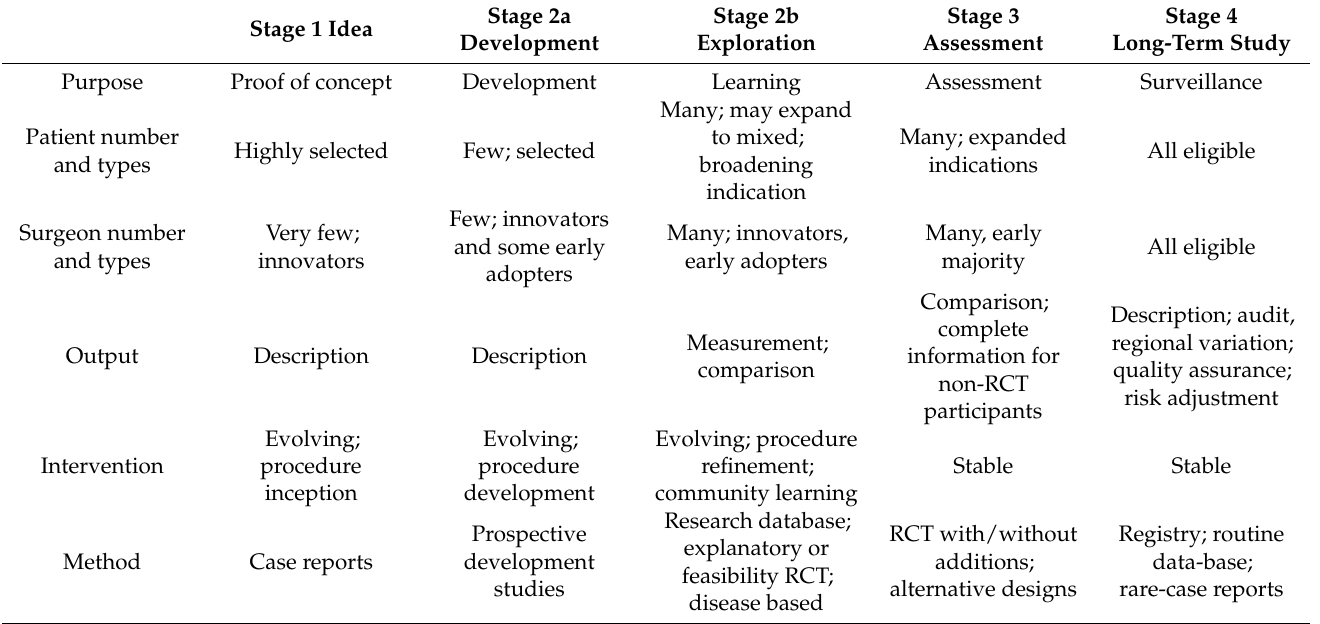
Table 3. Stages of IDEAL